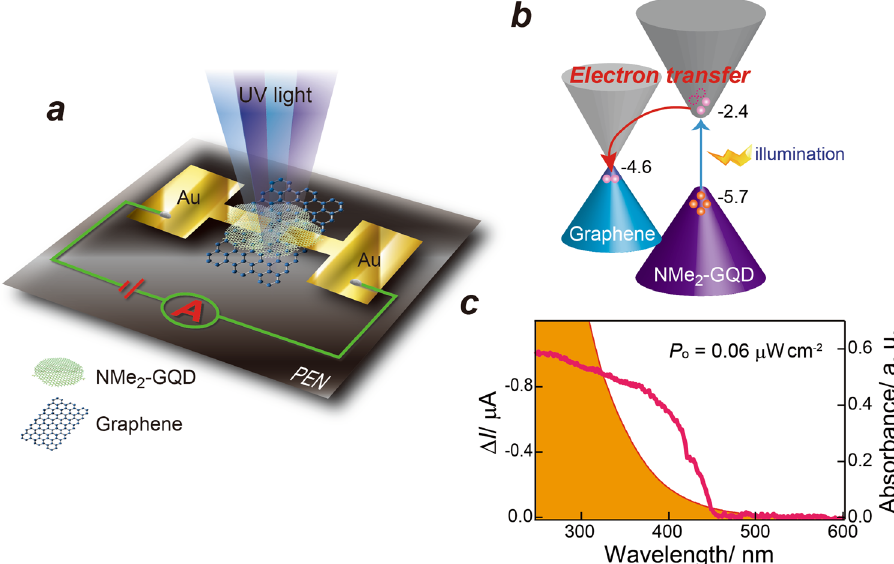
Figure 1. ( a ) Schematic representation of the NMe 2 -GQD@GFET hybrid photodetector. ( b ) Schematic diagram of the energy level alignment for the photodoping effect under illumination. Photoexcited electrons in the NMe 2 -GQDs are transferred to the graphene layer. ( c ) Spectral response (left axis) from the NMe 2 -GQD@ GFET photodetector ( V SD = 0.1 V, V G = 0 V, 0.06 μ W cm − 2 ). The solid orange spectrum (right axis) corresponds to the UV-vis absorption spectrum of a NMe 2 -GQD